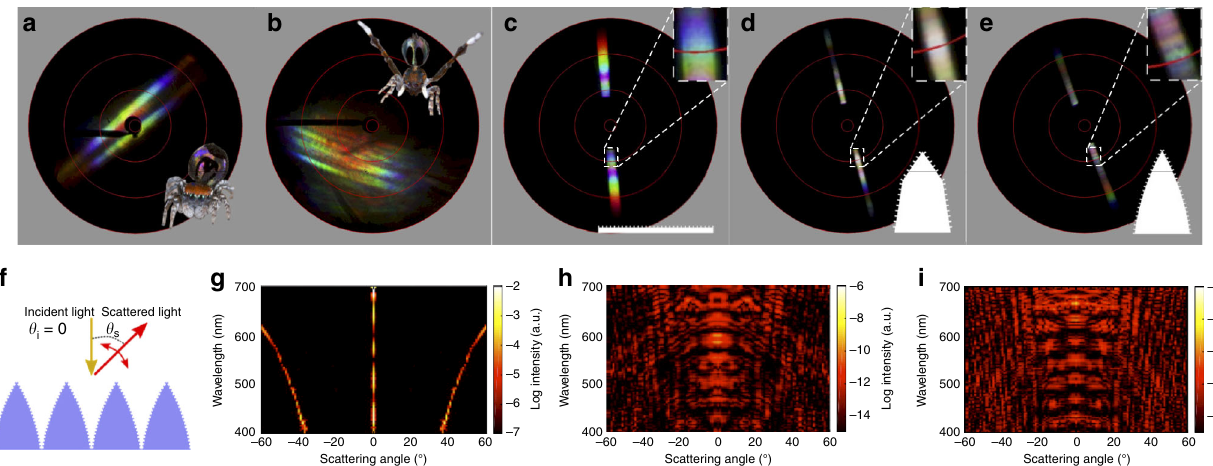
Fig. 6 Imaging scatterograms and fi nite element optical simulation. a – e Scatterograms from iridescent scales of M. robinsoni ( a ), M. chrysomelas ( b ), from 3D printed fl at grating ( c ), prism grating ( d ), and foil grating ( e ). The red circles from the centre out indicate 5°, 30°, 60°, 90° accordingly. The black centre of c – e is due to the 3D printed samples blocking the near-axis re fl ection in the scatterometer. Reverse-ordered diffraction patterns are observed in a , b , d , and e (see also insets). Fine banded patterns are observed in d and e only. f , Diagram of fi nite element optical simulations. g – i Results of fi nite element optical simulations for the 3D printed fl at ( g ), prism ( h ) and foil ( i ) gratings. h , i Reverse-ordered diffraction patterns corresponding with d and e . Only i shows increased resolving power (i.e., fi ner diffraction